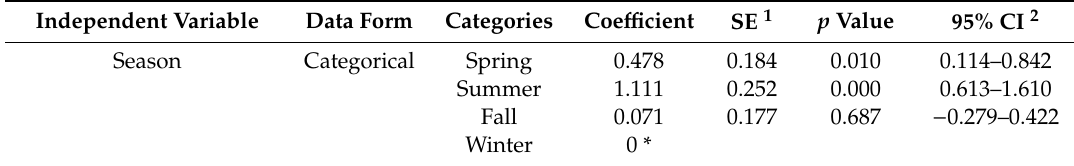
Table 7. Final generalized linear mixed model based on 120 farm visits describing risk factors ( = independent variable) associated with log 10 -transformed teat-skin load at herd level with esculin-positive streptococci ( = dependent